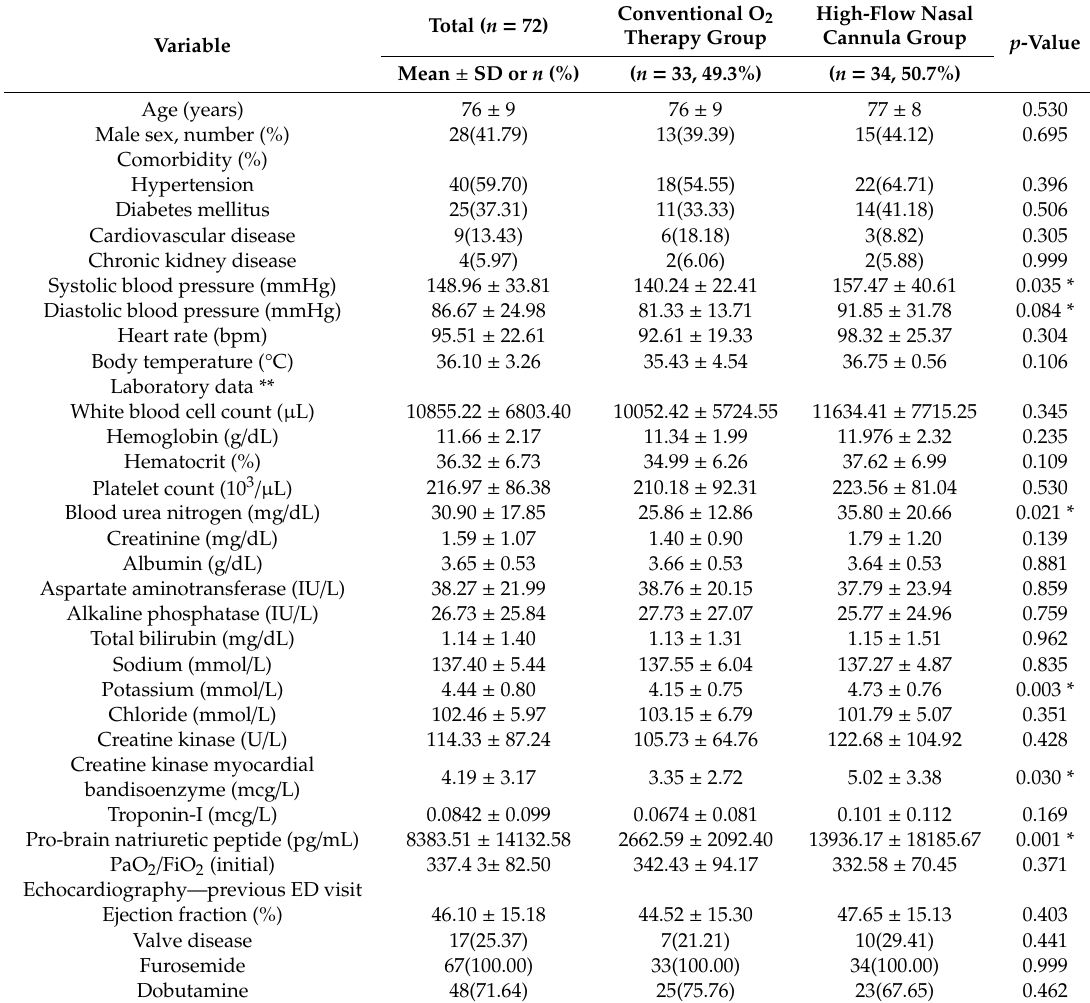
Table 1. Baseline characteristics of patients.